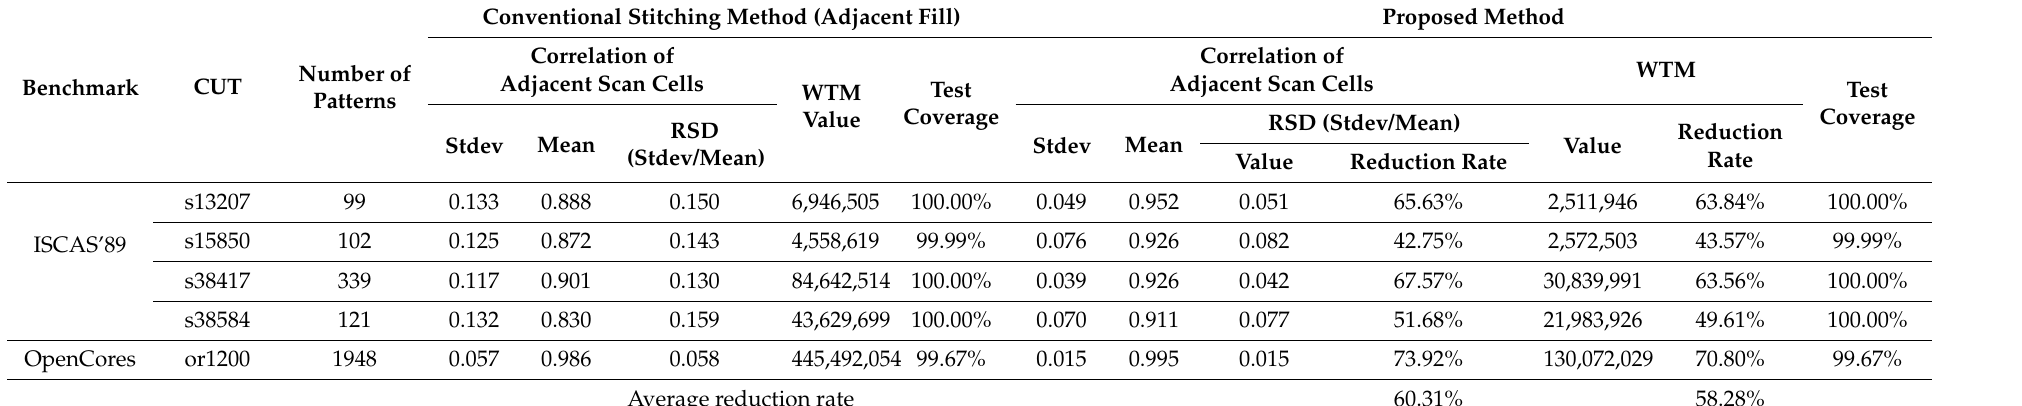
Table 1. Comparison of the correlations of adjacent scan cells and power consumption.